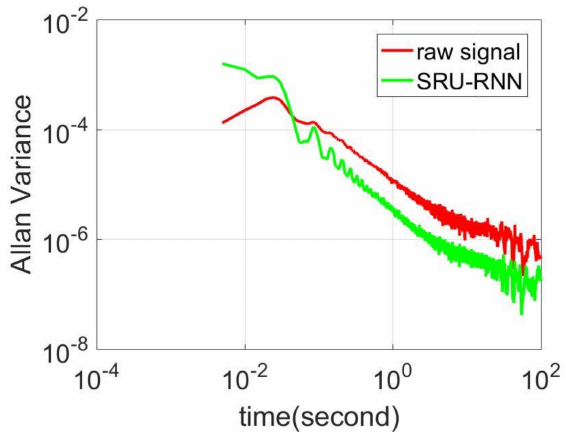
Figure 14. Allan variance comparison between de-noised and raw signals for Z-axis gyroscope.